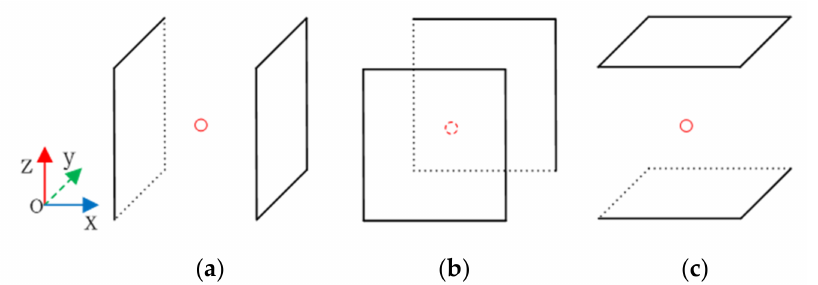
Figure 3. ( a ) The surface obstacle is in the orthogonal directions of x -axis. ( b ) The surface obstacle is in the orthogonal directions of y -axis. ( c ) The surface obstacle is in the orthogonal directions of z -axis.